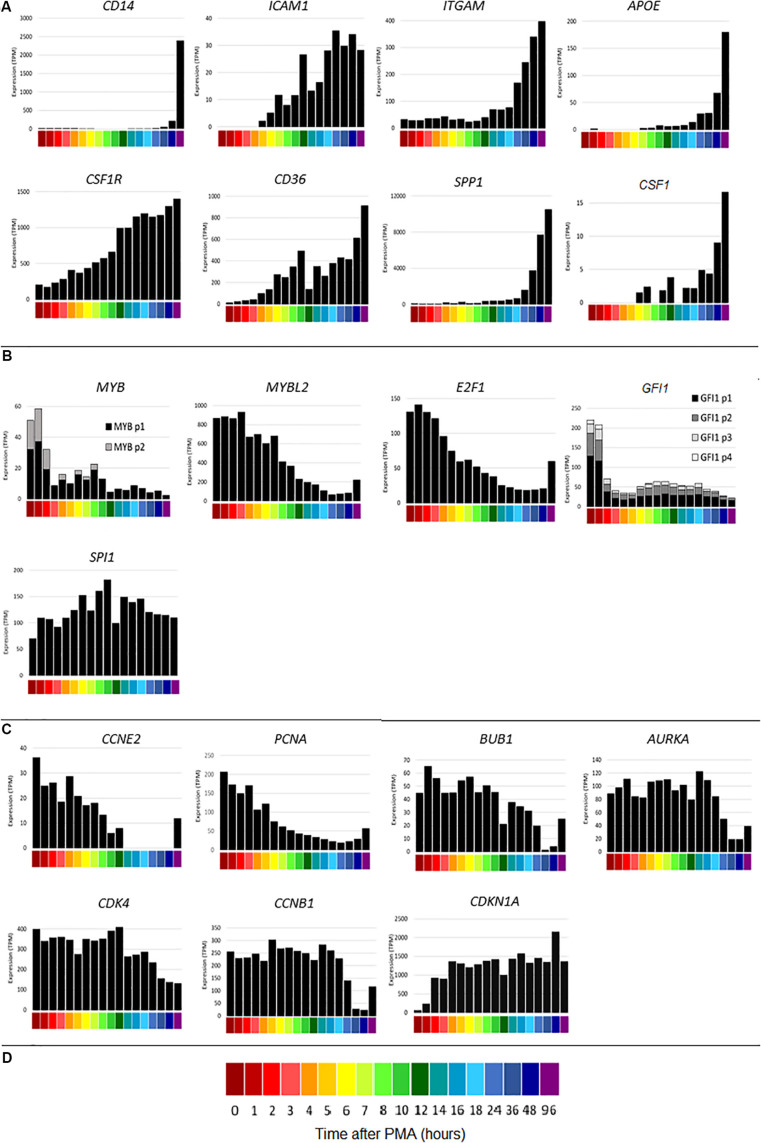
Gene expression during differentiation of THP-1 cells. X axis shows time points from 0 to 96 h after administration of PMA; Y axis shows average expression by CAGE analysis in tags per million (TPM). (A) Macrophage differentiation marker genes CD14, ICAM1, ITGAM, APOE, CSF1R, CD36, SPP1, CSF1.
(B) Transcription factor genes MYB (two CTSS), MYBL2, E2F1, GFI1 (four CTSS), SPI1. Multiple CTSS associated with the same gene are shown by lighter colored sections of the bars. (C) Inducible cell cycle repressor genes CCNE2, PCNA, BUB1, AURKA, CDK4, CCNB1, CDKN1A.
(D) Color code for time points on the X axis.